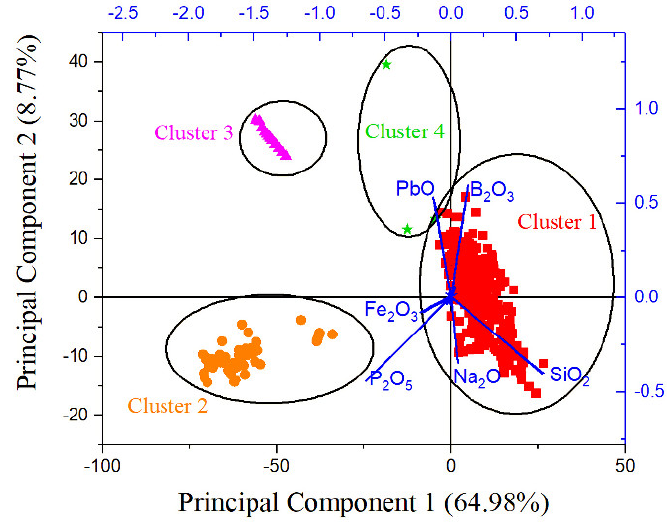
Figure 4. Biplot of principal component 1 (related mainly to SiO 2 , P 2 O 5 , Fe 2 O 3 , B 2 O 3 , and PbO contents) versus principal component 2 (related mainly to PbO, B 2 O 3 , Na 2 O, SiO 2 , and P 2 O 5 ) considering all waste glass compositions and the covariance matrix. Borosilicate glasses are predominant and located at the center. It is possible to map all glasses in four clusters related to hierarchical and non-hierarchical results. All other variables were discarded from this biplot for a better view of the main oxides. Table 2. Total and cumulative percentages and respective eigenvalues of each axis considering the covariance mode.